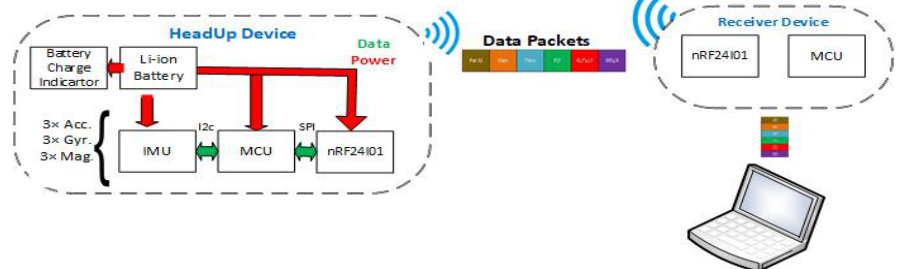
Figure 3. HeadUp system architecture.